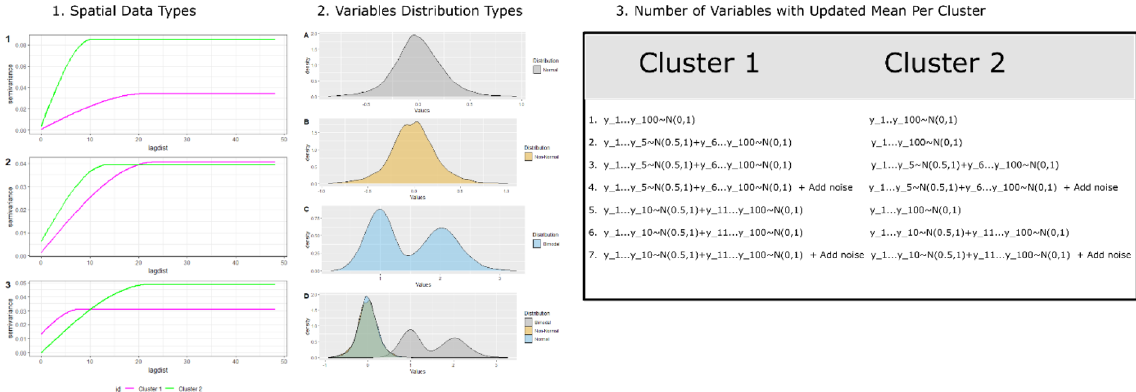
Figure 2. The three main categories for synthetic data generation in a simulation study. ( 1 ) The synthetic data with different spatial structures were generated using different input in variogram function (spatial data1: range1 = 20, range2 = 20, sill1 = 0.1, sill2 = 0.3; spatial data2: range1 = 20, range2 = 10, sill1 = 0.1, sill2 = 0.1; spatial data3: range1 = 20, range2 = 10, sill1 = 0.1, sill2 = 0.3). ( 2 ) The variables in synthetic data are derived from different statistical distributions: normal, non-normal, bimodal, and all combined. ( 3 ) The synthetic data was modified by increasing the mean value for a certain number of variables and adding the